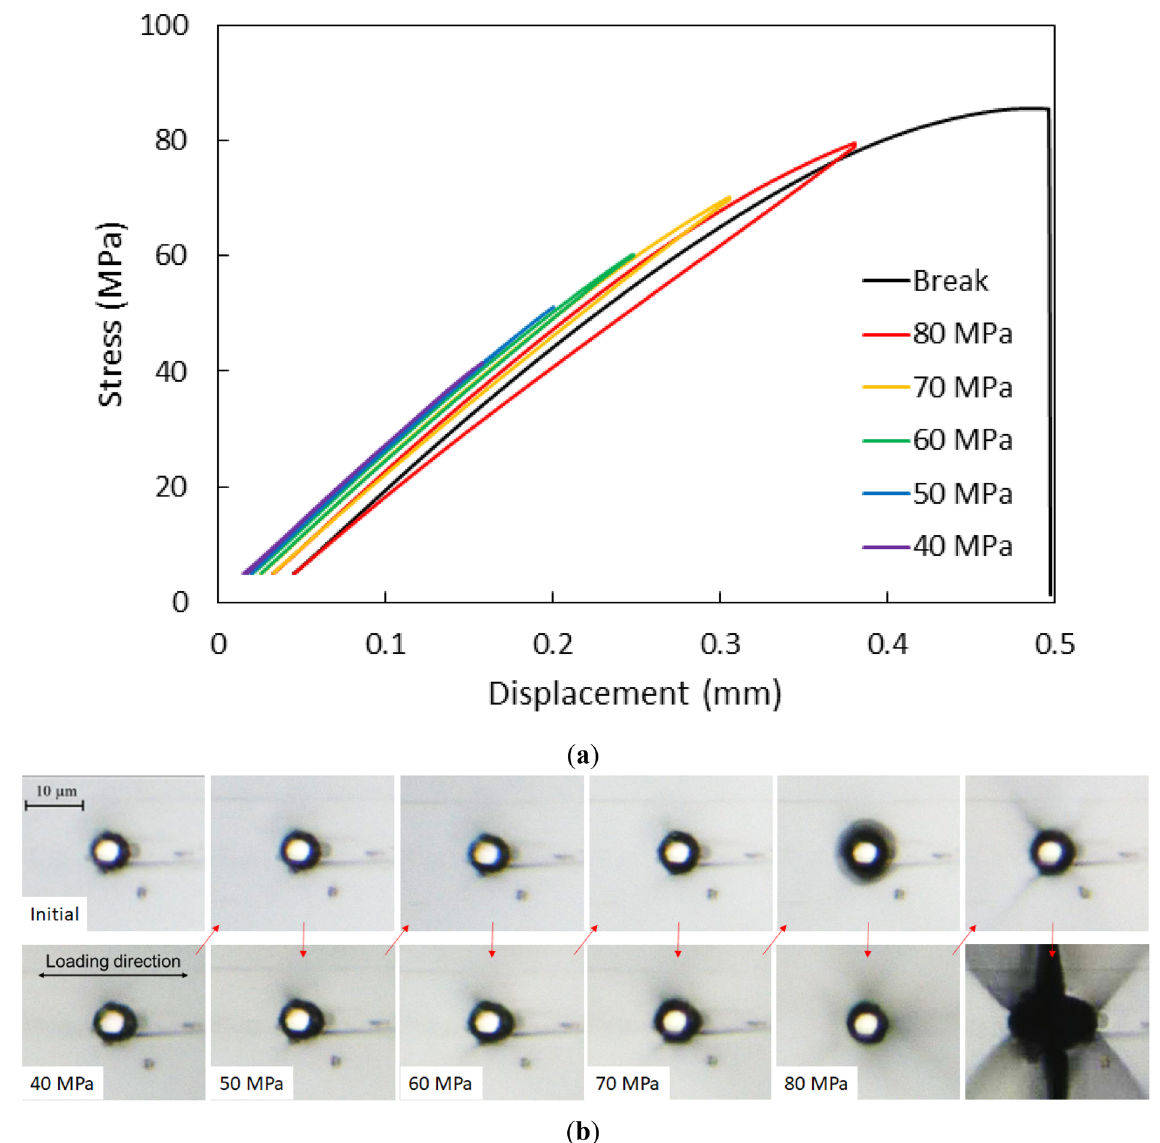
Figure 7. ( a ) Loading–unloading curve of the epoxy sample embedded with a single carbon fiber. The gradual increase in residual displacement after unloading implies the progress of the interfacial debonding. ( b ) Optical images observed under high-magnification microscope before and after unloading with an increment of 10 MPa until fracture. The lower and upper images were captured before and after unloading at each loading cycle, respectively. The dark boundary zone became gradually thicker at the higher loadings, and confirming the interfacial debonding by observing the sample surface was